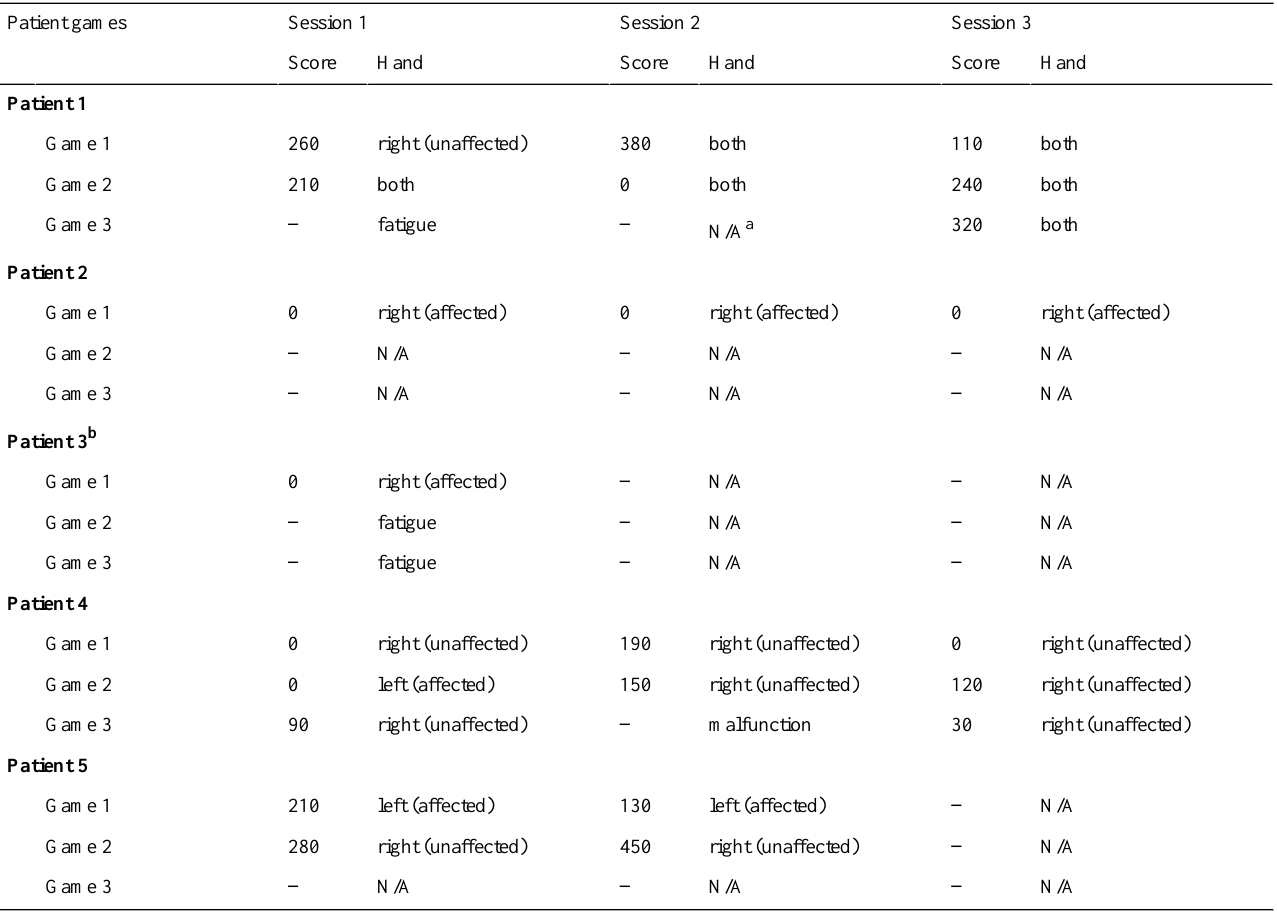
Table 2. Patient game sessions with the number of points scored, the hand chosen by the patient for play during a given game, and the functional status of the